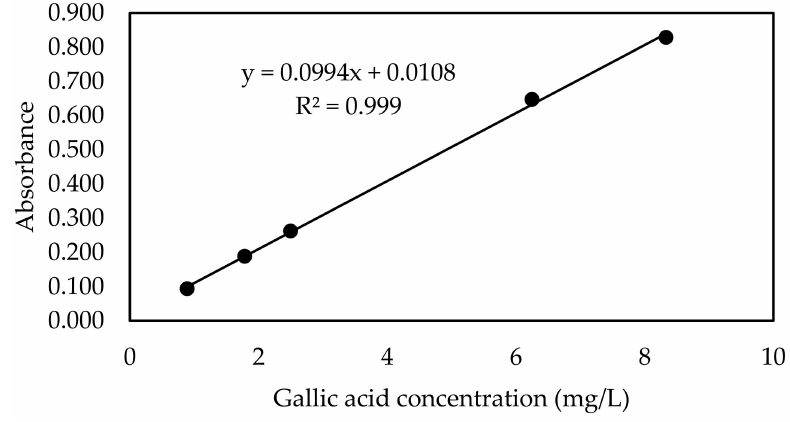
Figure A1. Calibration curve for phenolic compounds.